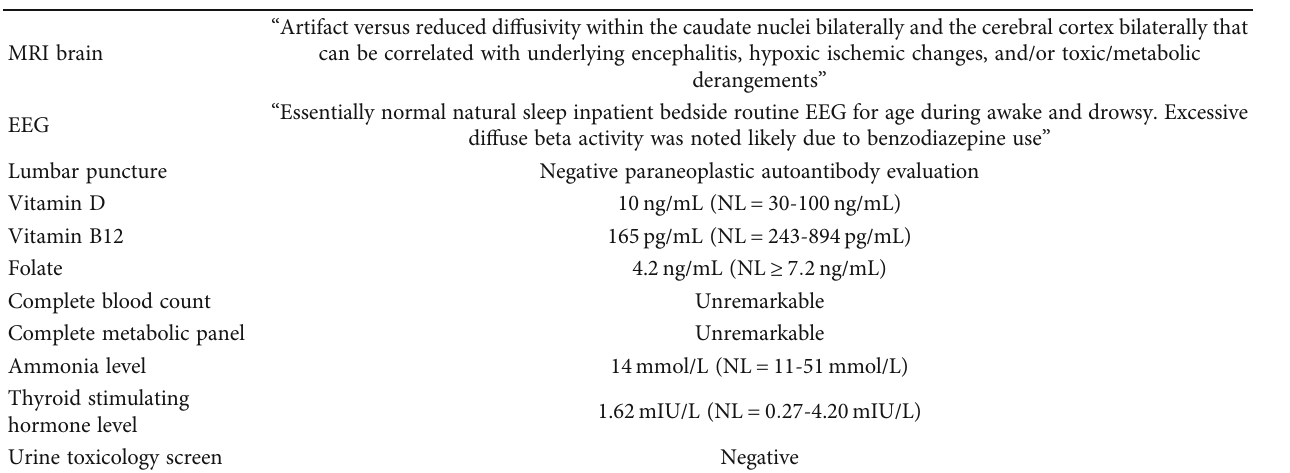
Figure 1: Fetal cardiotocography tracing on admission to labor and delivery. Table 1: Summary of diagnostic fi